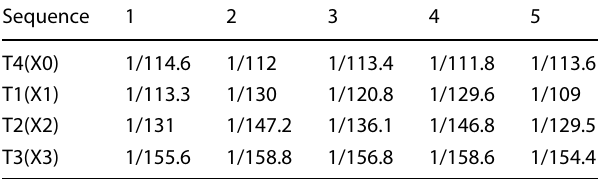
Table 5 Analysis of sequence